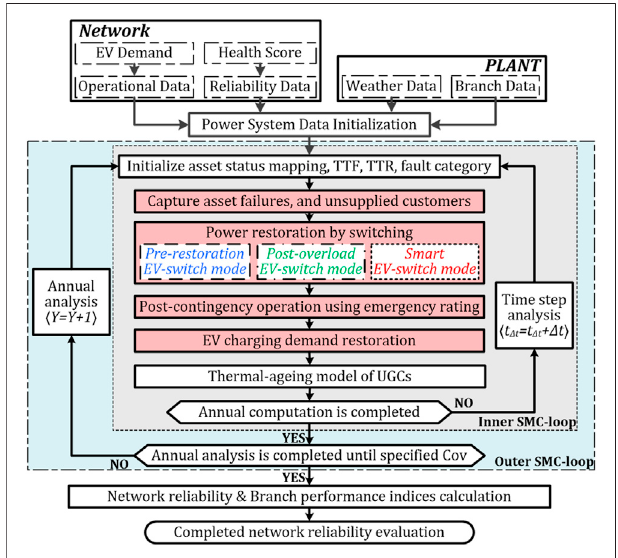
FIGURE 1| Methodological fl owchart for evaluating the EV impact in the distribution